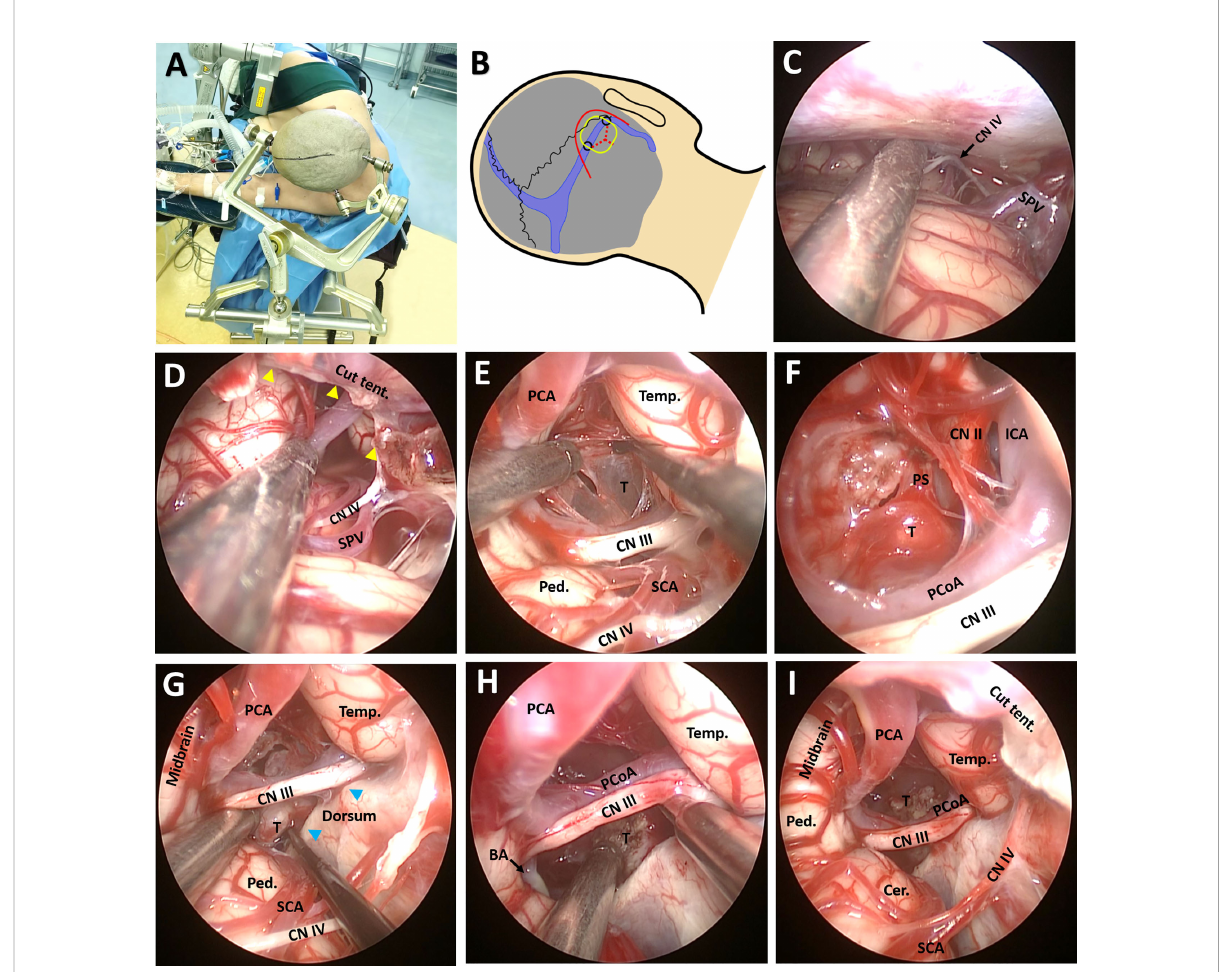
FIGURE 3 Surgical procedure and nuances of the EF-SCITA approach. (A) The lateral prone position for a right-sided EF-SCITA approach. (B) Head position and surface landmarks for the transverse/sigmoid, the curved skin incision (red line), the proposed bone window (yellow rounded rectangle), the mark for drilling sites including the asterion and another site located 3.5 cm medial to the asterion (black circles), and the Y- shaped durotomy (red dotted lines). (C) Endoscopic explorations in the lateral supracerebellar infratentorial space. (D) The incision of the tenrorium for exposure of the crural cistern. The yellow arrowheads denote the edge of the cut tentorium. (E) The exposure of the posterior capsule of the cystic lesion in the supra-oculomotor space. (F) The exposure of the solid part of the tumor in the supra-oculomotor space after aspiration of the contents. (G, H) Dissection of the solid tumor from the pituitary stalk in the infra-oculomotor space. The anatomical boundaries of the supra-oculomotor and infra-oculomotor spaces are clearly seen. The blue arrowheads indicate bilateral posterior clinoid processes. (I) The endoscopic view of subtotal removal of the tumor, with a small part of the solid lesion adhering to the pituitary stalk left. BA, basilar artery; Cer, cerebellum; CN II, optic nerve; CN III, oculomotor nerve; CN IV, trochlear nerve; ICA, internal carotid artery; PCA, posterior cerebral artery; PCoA, posterior communicating artery; Ped., pedunculus cerebri; PS, pituitary stalk; SCA, superior cerebellar artery; SPV, superior petrosal vein; T, tumor. Temp., temporal lobe; Tent.,